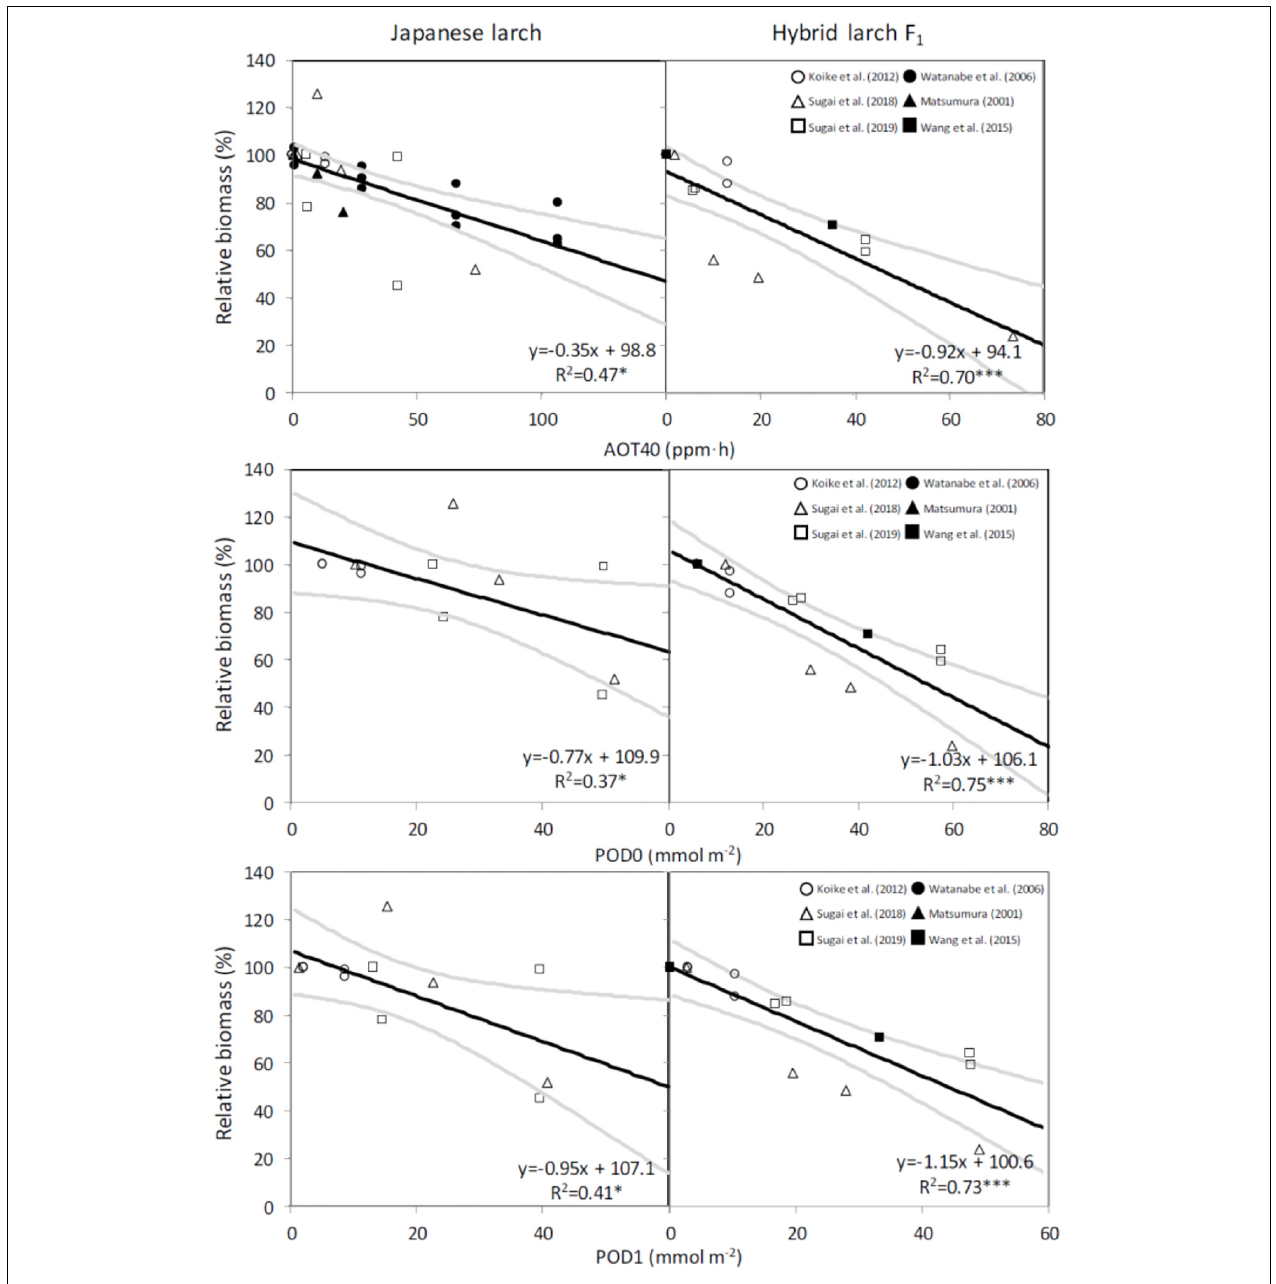
FIGURE 2 | Dose–response relationships for total biomass losses in two species of larch seedlings on the basis of AOT40, POD0, or POD1 in different experiments. Black lines denote the regressions, and gray lines denote the 95% confidence intervals. Asterisks show the level of significance: *** p ≤ 0.001; * p ≤ 0.05.